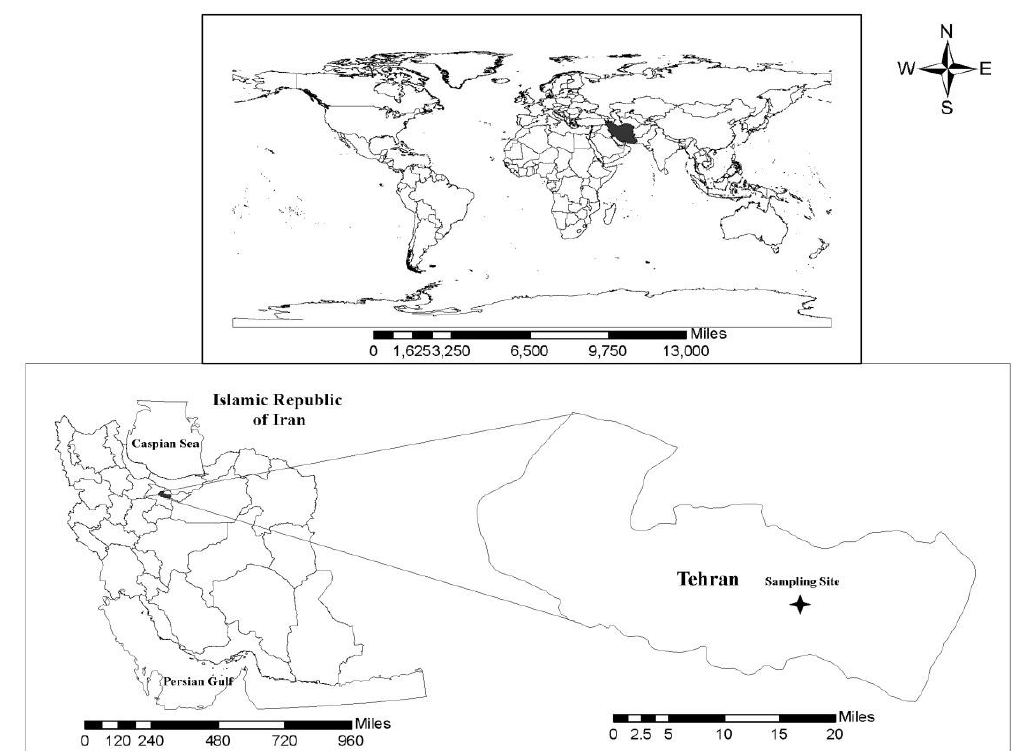
Figure 1. Location of the sampling site in